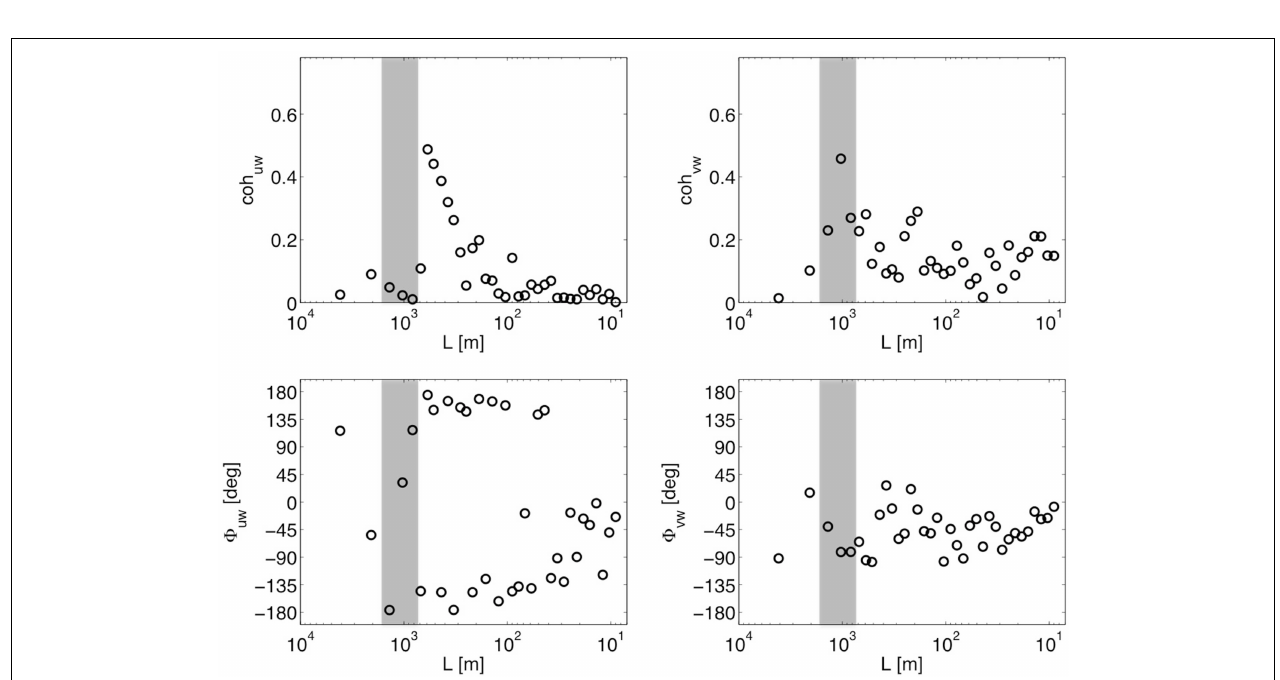
FIGURE 5 | Potential temperature at the two lower flight legs along the analyzed segment.